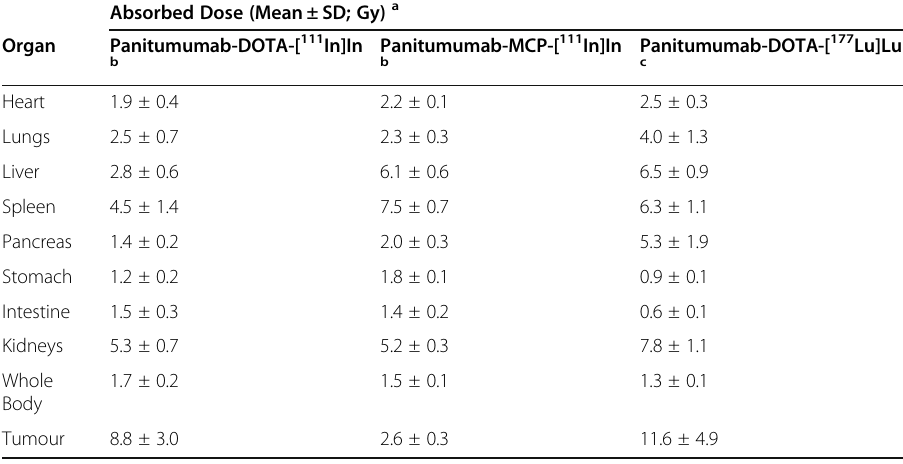
Table 2 Absorbed doses in the tumour and normal organs in mice with subcutaneous PANC-1 xenografts treated with RICs Absorbed Dose (Mean ± SD; Gy)